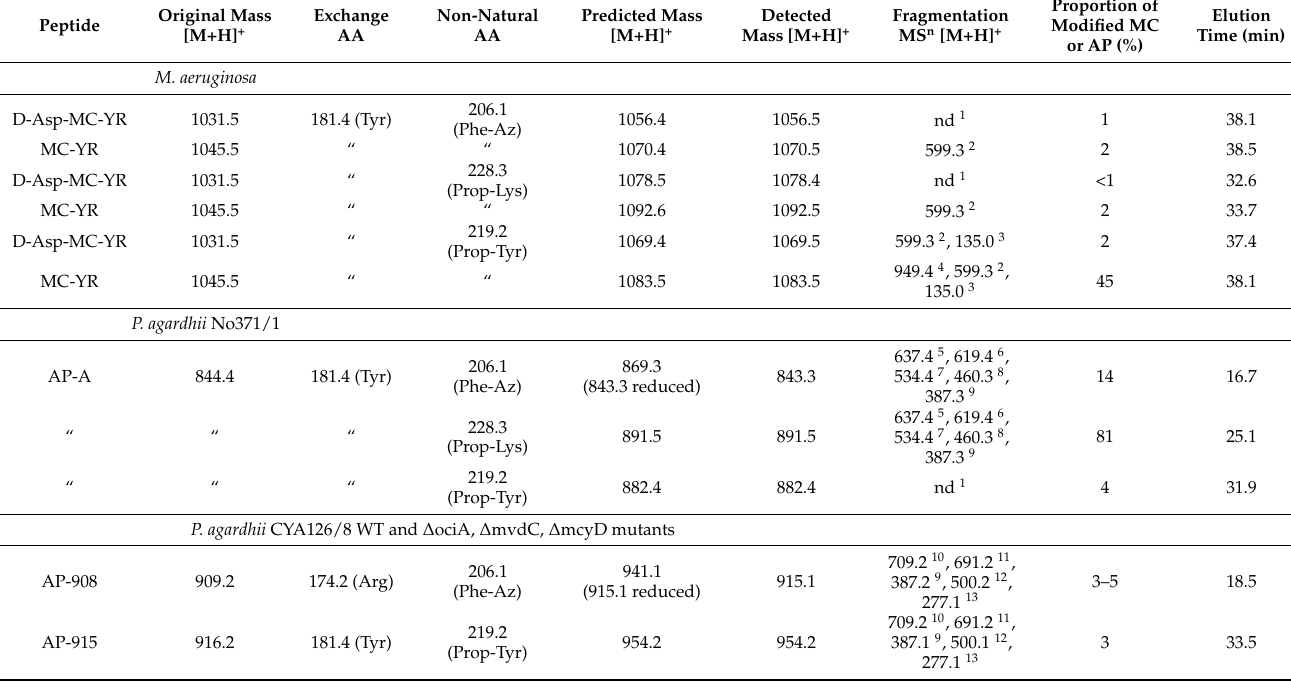
Table 1. Protonated masses [M+H] + of modified MCs and APs structural variants for the cyanobacteria M. aeruginosa and P. agardhii . Masses of the modified peptides were calculated by replacing the natural amino acid with the non-natural amino acid at pos.2 (MC) or pos.1 (AP). Observed MS n fragments are listed according to [30,31] for MCs or [2,32,33] for APs. Non-natural amino acid incorporation is calculated as a percentage of natural structural variants produced under control